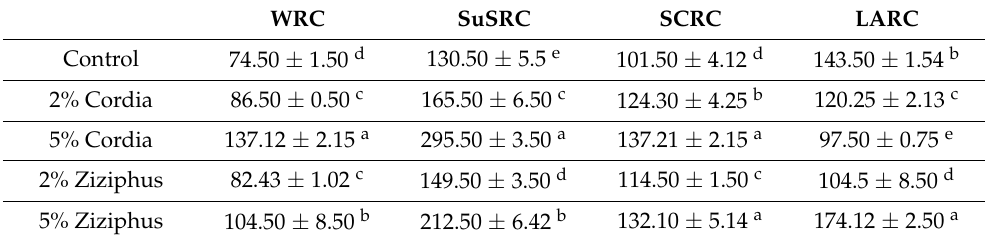
Table 2. Solvent retention capacity properties of flour gum blends.